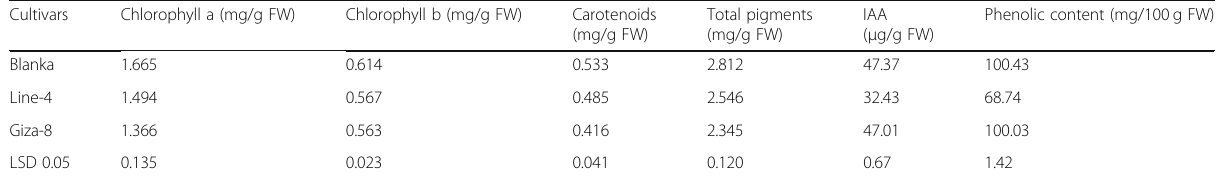
Table 3 Effect of cultivars on photosynthetic pigments, IAA, and phenolic contents of flax plants grown under sandy soil conditions (data are means of two successive seasons) Cultivars